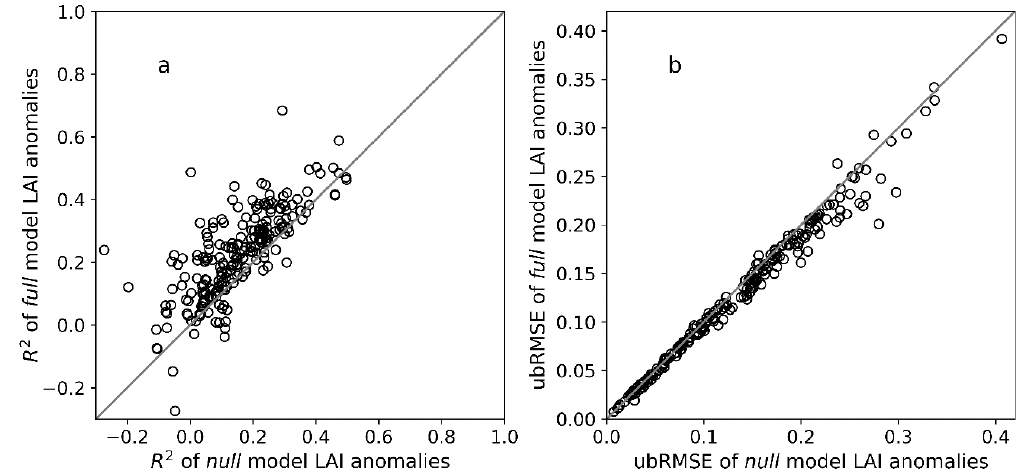
Figure 3. The R 2 s of “ full ” model predicted LAI anomalies against the R 2 s of the “ null ” model predicted LAI anomalies ( a ), and ubRMSE of “ full ” model predicted LAI anomalies against the of the “ null ” model predicted LAI anomalies ( b ). Table 1. Statistics of “ null ” model R 2 s and “ full ” model R 2 s for LAI anomaly predictions and the statistics of the difference in R 2 s between the “ full ” models and “ null ” models and for the LAI anomaly prediction. (asterisks indicate the R 2 s of the models are significantly greater than 0 with different significant levels * 0.05; ** 0.01).